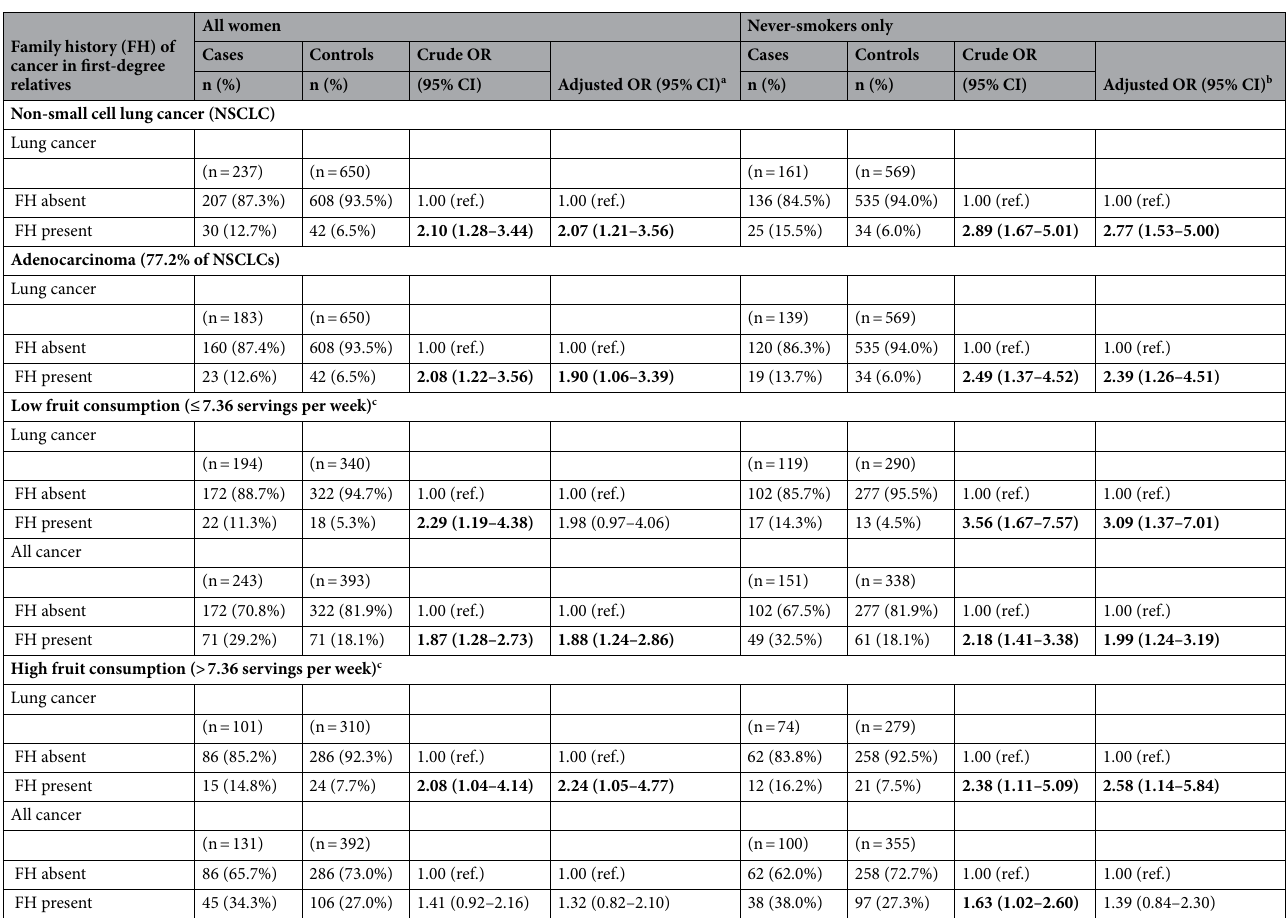
Table 3. Odds ratio (OR) and 95% confidence interval (CI) of the association between family history and lung cancer risk, stratified by histologic type of lung cancer and fruit consumption. a Adjusted for age, type of dwelling, years of education, ETS exposure, BMI, history of respiratory disease, meat consumption, fruit consumption, vegetable consumption, frequency of cooking, and smoking status, excluded fruit consumption when stratified by fruit consumption. b Adjusted for age, type of dwelling, years of education, ETS exposure, BMI, history of respiratory disease, meat consumption, fruit consumption, vegetable consumption and frequency of cooking, excluded fruit consumption when stratified by fruit consumption. c The cutoff for low and high fruit consumption was determined by the median weekly servings of fruits that controls reported (7.36 servings/week). Bold values refer to statistically significant results with P